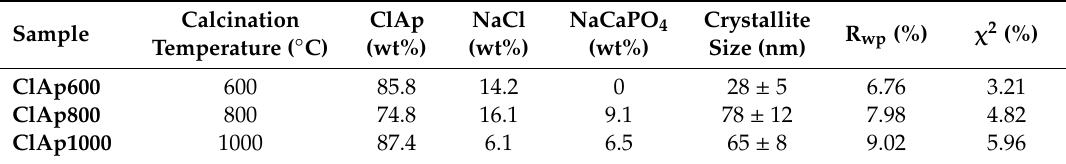
Table 1. Volume fraction of phases and crystallite size of ClAp powder derived from fish scales at di ff erent calcination temperatures.